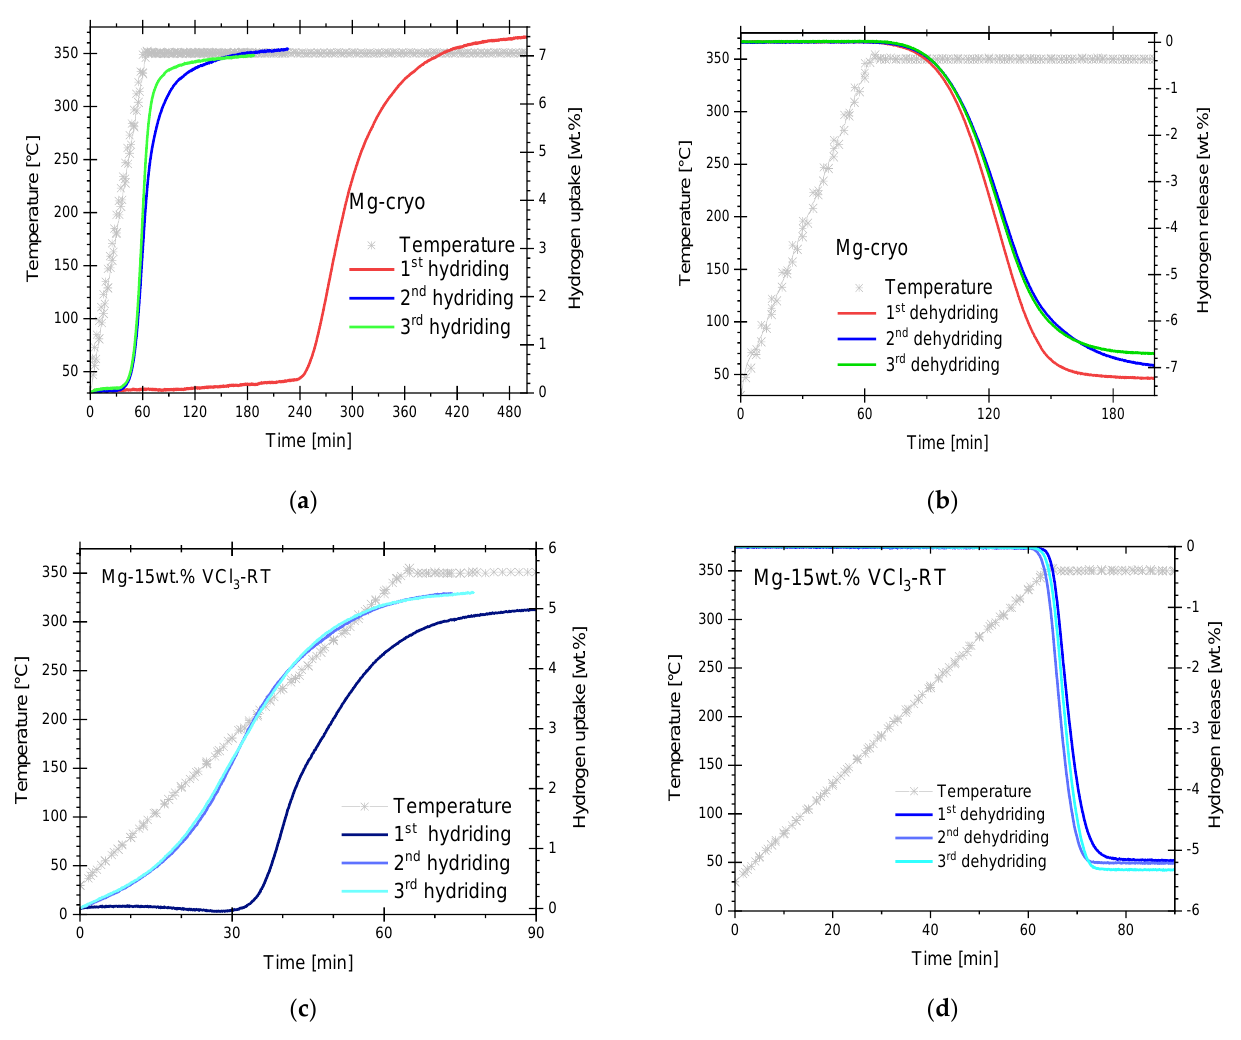
Figure 7. ( a ) Hydriding/( b ) dehydriding cycles of cryogenically milled Mg. ( c ) Hydriding/( d ) dehydriding cycles of Mg-15wt.%-RT (milled at room temperature). Hydriding at 26 bar hydrogen pressure. Dehydriding at 0.8 bar hydrogen pressure.